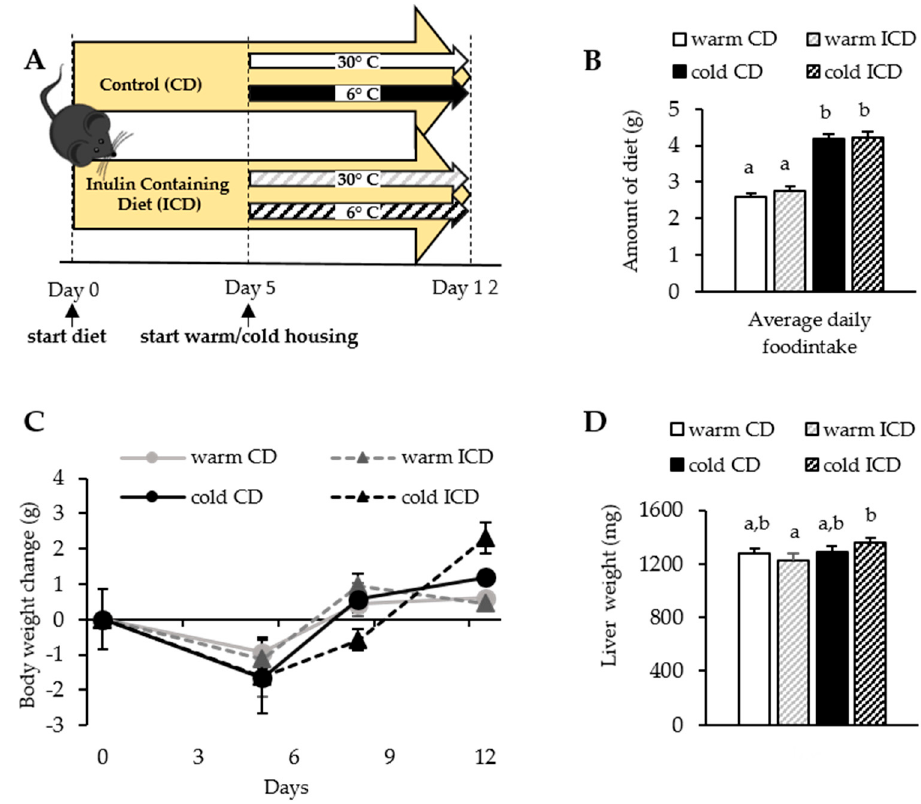
Figure 1. Short-term inulin supplementation does not alter body weight. ( A ) Study design: C57BL/6J mice were fed an inulin containing diet (ICD) or a respective control diet (CD) for 12 days, and were housed at 30 °C (warm) or 6 °C (cold) for seven days; ( B ) average daily food intake; ( C ) body weight change over time, and ( D ) liver weight after 12 days of feeding. Data are shown as mean values ± SEM; CD warm: n = 6; ICD warm: n = 6; CD cold: n = 6; ICD cold: n = 5; different letters indicate significant differences between groups ( p < 0.05) determined by two-way ANOVA.